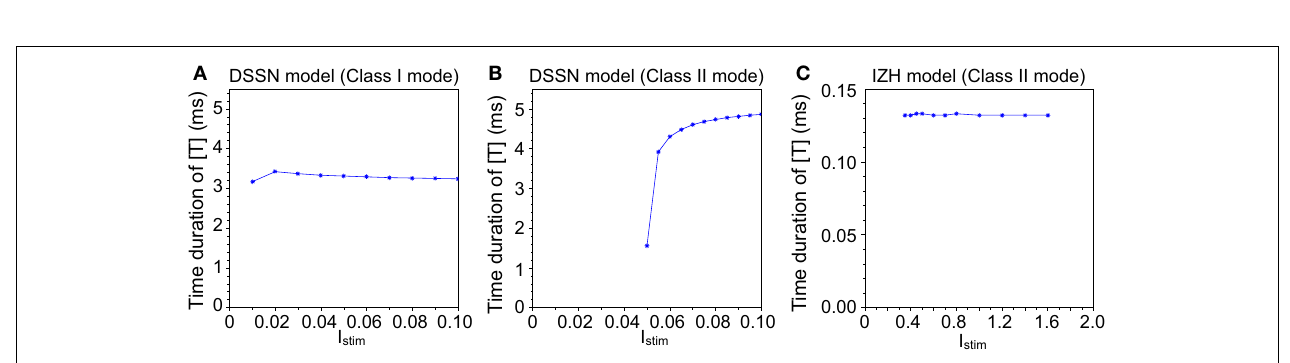
FIGURE 3 |The time duration of the transmitter release in our silicon synapse model connected to the DSSN model in (A) Class I and (B) Class II modes and (C) the IZH model. Each neuronal model is in the oscillatory state in response to the sustained stimulus I stim